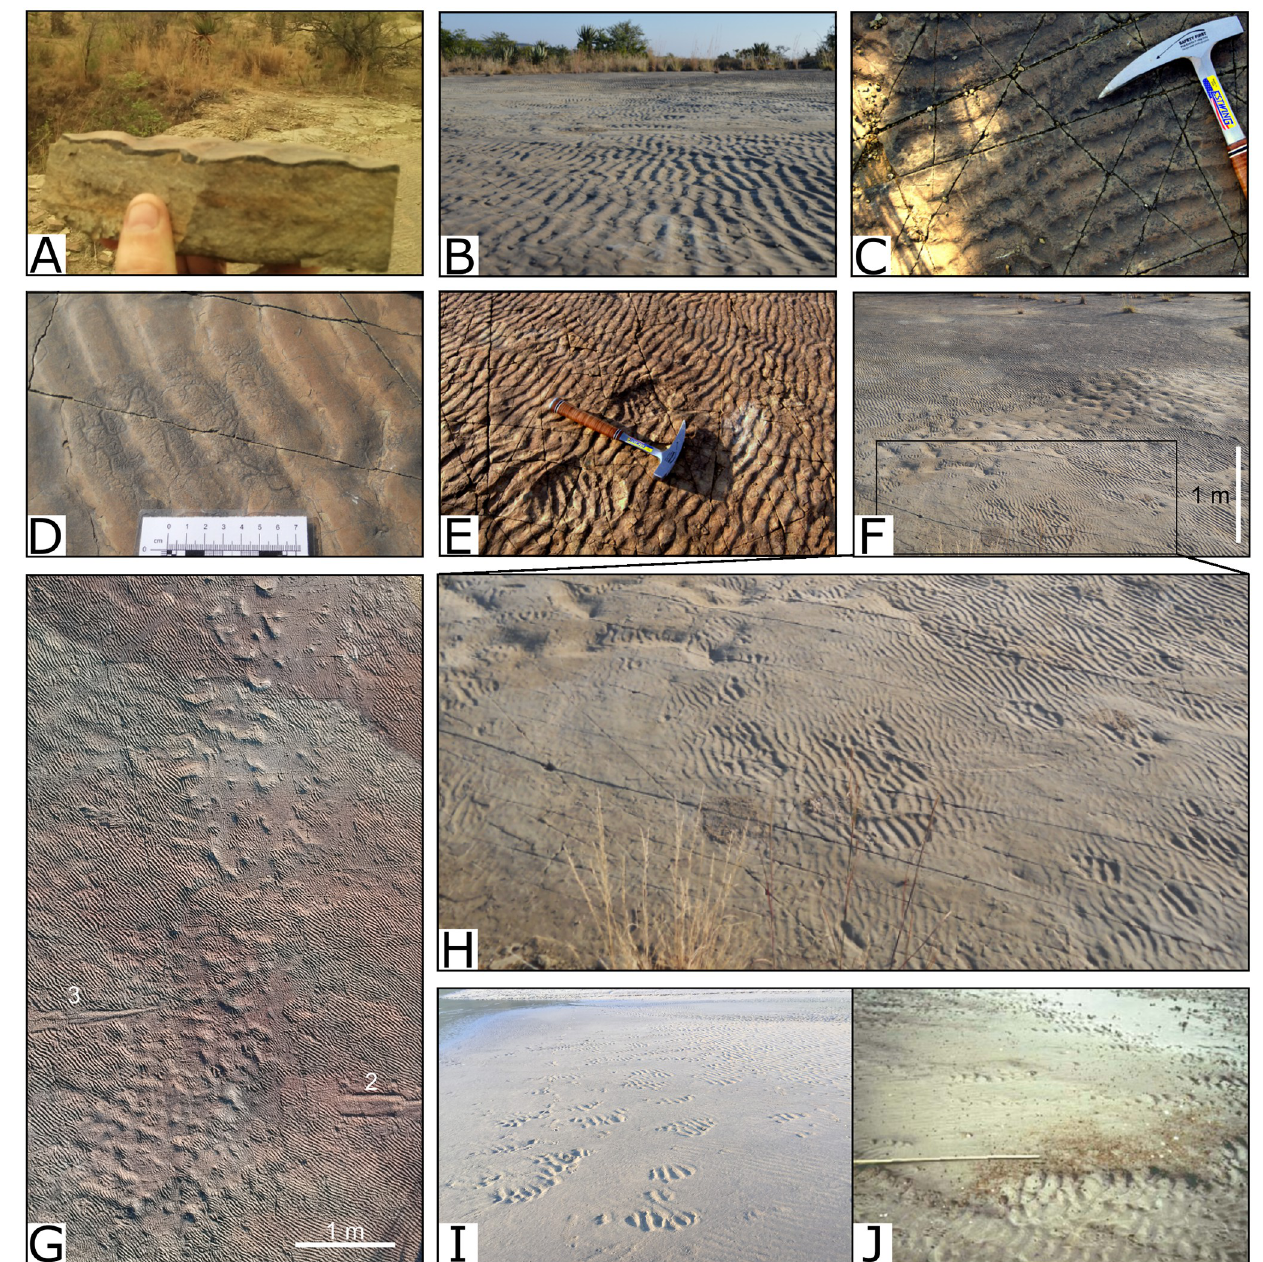
Fig 4. Sedimentary structures preserved on the palaeosurface. A and B) Well preserved asymmetrical ripples indicate a westerly current direction. C) Current-modified ripples, with tongues of sand on the lee side of the ripples, in the northwestern part of the surface. D) Rill marks on smoothed ripple marks in the northwestern part of the surface. E) Depressions with interference ripples F) Smooth, unrippled section in the foreground with rippled surface in the background and a ‘corridor’ of subcircular to blob-shaped depressions (tracks) between the two. G) Aerial view of the portion of the ‘corridor’ passing between impressions 2 and 3. H) Closer view of smooth areas surrounded by ripple marked depressions which could indicate the presence of a microbial mat on the surface, as seen in modern environments (I and J). I) Modern example of smooth areas surrounded by ripple marked depressions at the Mbotyi River Mouth, South Africa. J) Modern example of an algal mat and ripple patches from Mellum Island tidal flats, Germany (modified from [61]).